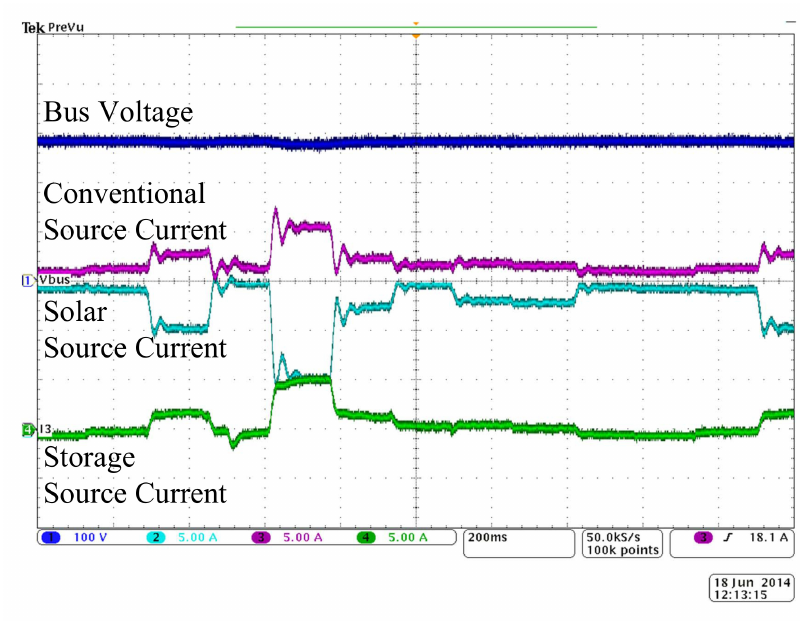
Figure 15. Hardware-in-the-loop results with optimal high dimension droop control: Ch1 Bus Voltage;